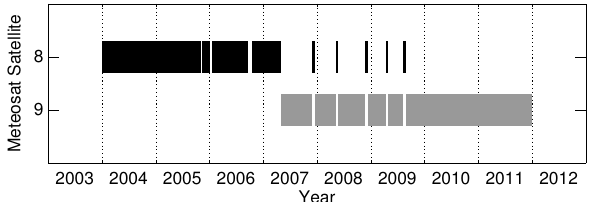
Fig. 1. Temporal coverage of Meteosat-8/SEVIRI and Meteosat- 9/SEVIRI measurements as taken in operational service and as used as the basis for the presented CLAAS data set. Gaps in Meteosat- 9/SEVIRI measurements are filled with Meteosat-8/SEVIRI data if exceeding one day. Gaps in the Meteosat-8/SEVIRI record remain